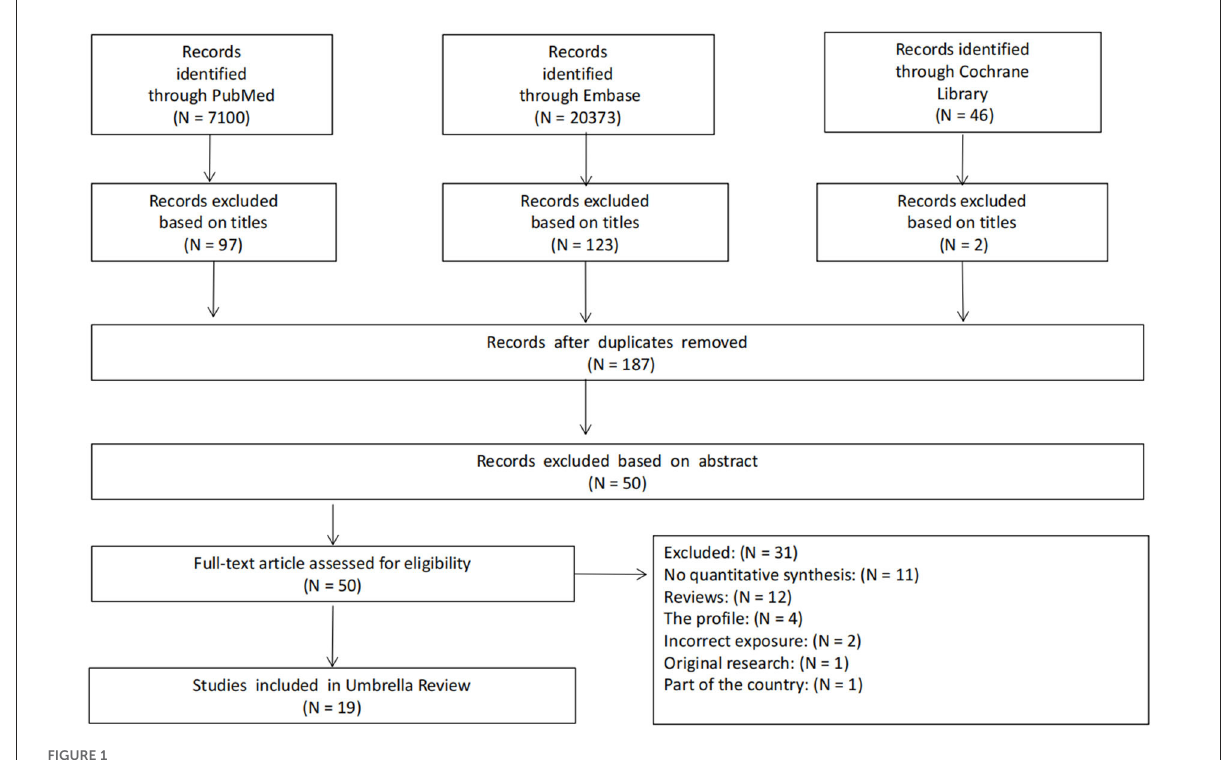
FIGURE1 Flow diagram of literature search and study